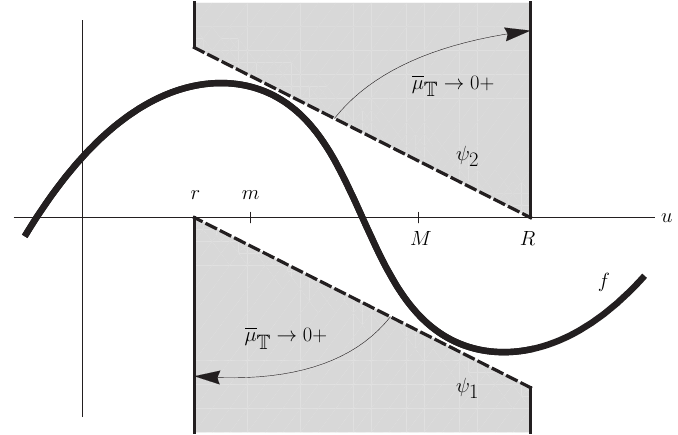
Figure 2: Illustration of (H6). The values r , R are chosen so that the function f (⋅ , x , t ) does not intersect the gray forbidden areas. The slope of the boundary dashed lines is determined by the values of μ 𝕋